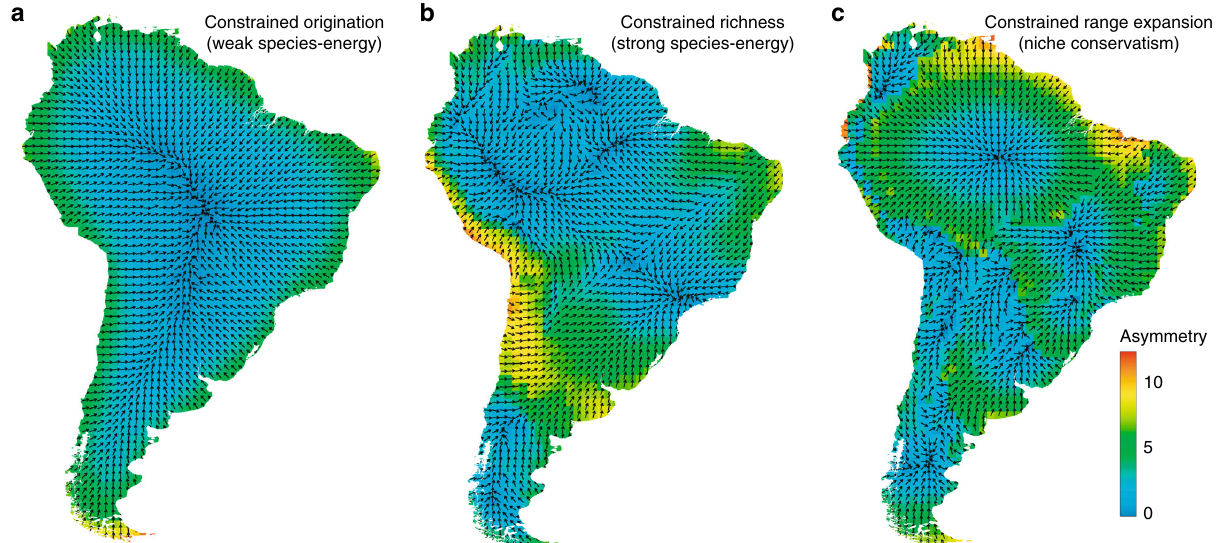
Fig. 5 Predicted assemblage dispersion fi eld (ADF) symmetry diagrams based on predictive models. The arrows reveal the pattern of biotic similarity. a The predicted ADF diagram from a model where species originate in grid cells according to local energy availability and then spread spatially randomly from there; b the predicted ADF diagram from a model where species richness is constrained to be identical to the empirical and ranges are constrained to be spatially cohesive; c the predicted ADF diagram from a model where each species originate in its original vegetation ecoregion and spreads spatially randomly with the constraint that ecoregion boundaries are crossed with low probability. Vegetation ecoregions are de fi ned by the map shown in Fig.